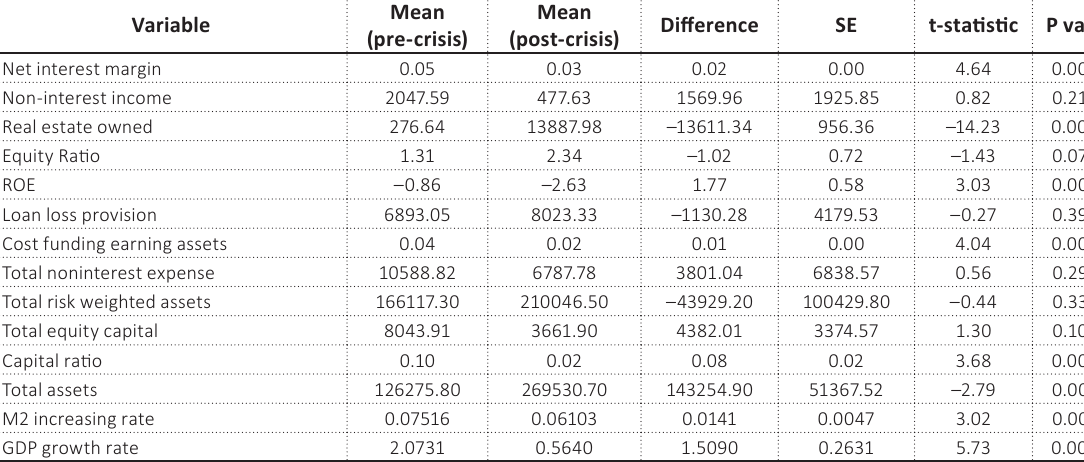
Table 3. Two-sample t-test